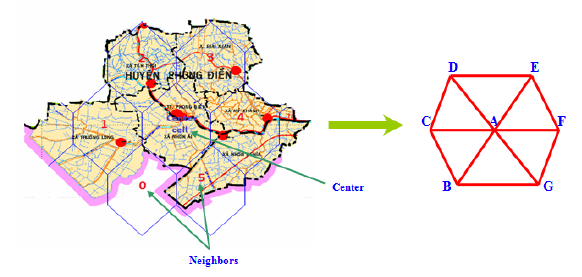
Figure 8. The graph of Phong Dien district,Canthowhenit is dividedas hexagonalcells.